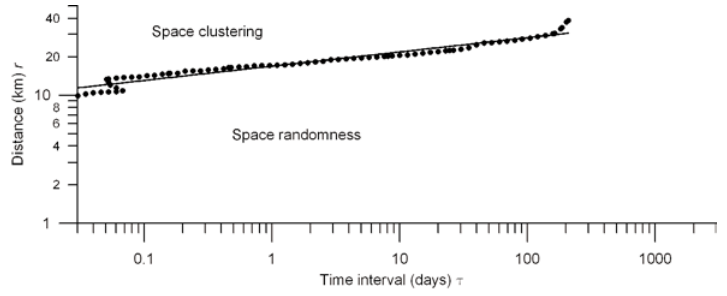
Fig. 6. The limit separating spatial clustering from spatial randomness (fixed to D s =1.0 ) as a function of time is shown. Points are fitted by the line of equation log r = 0.1log τ+